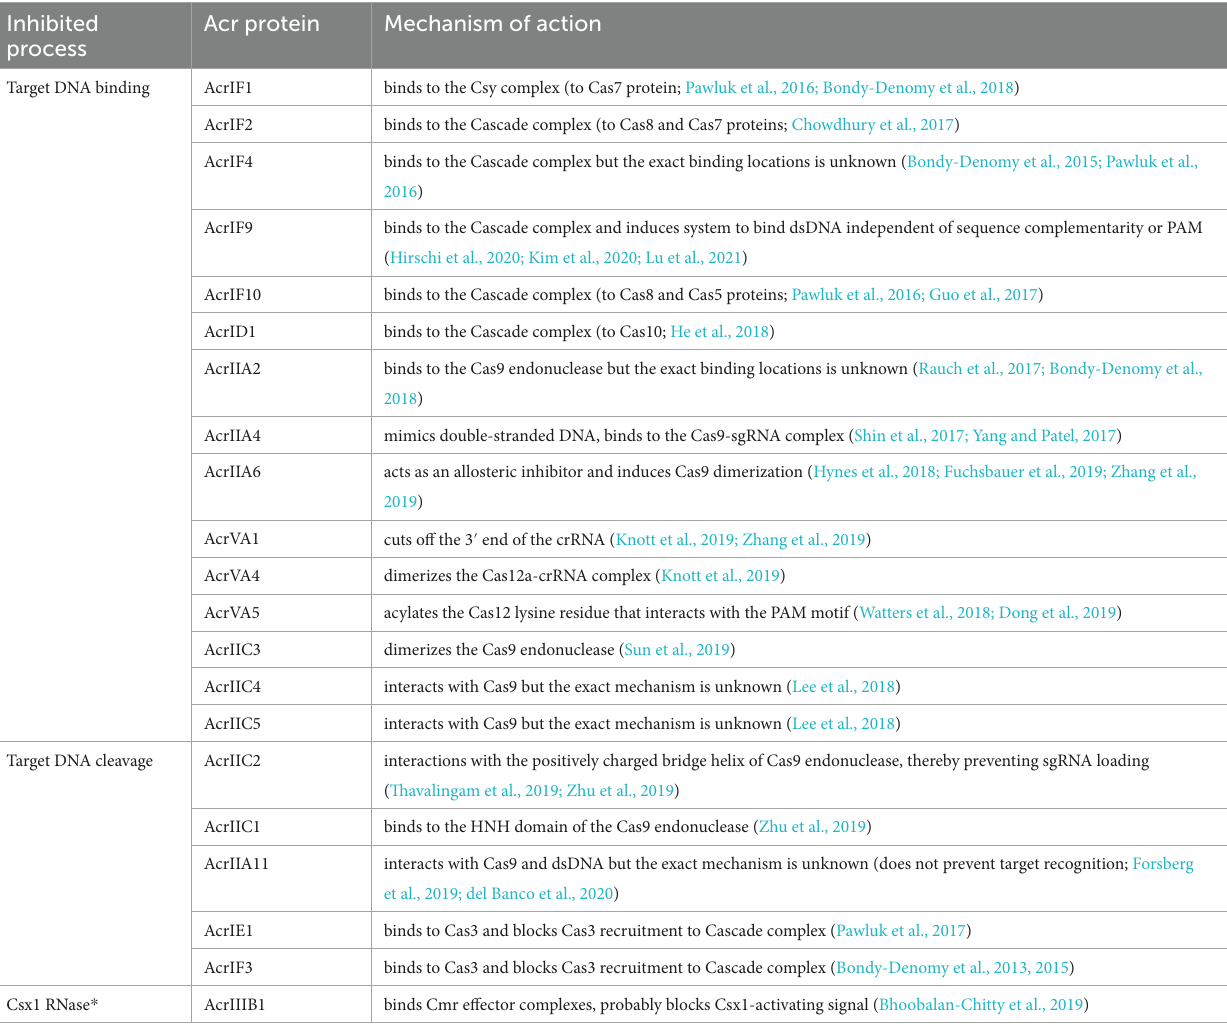
TABLE 1 Anti-CRISPR proteins mechanism of action. Adapted from Marino et al. (2020) and Wang et al. (2021). Inhibited process